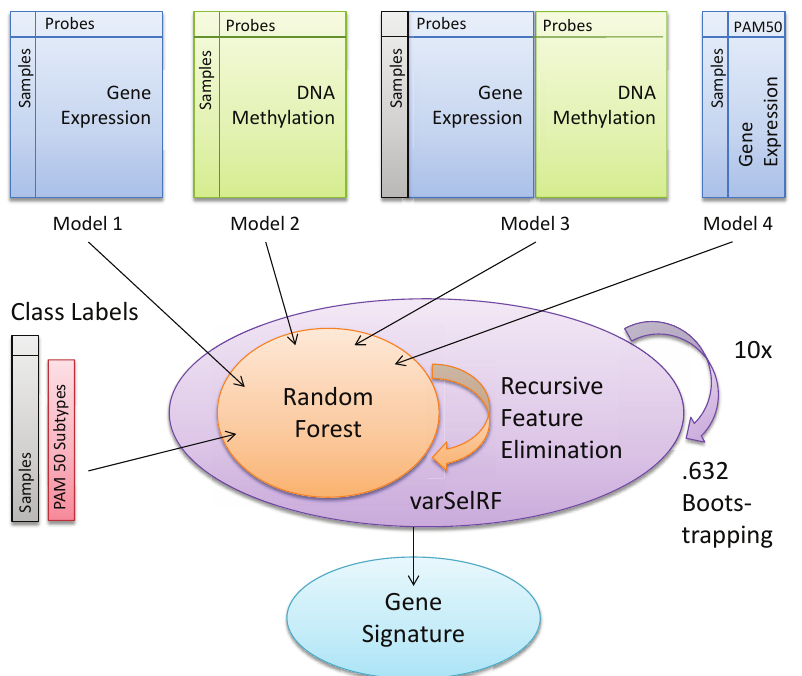
Figure 1: Four different models were created using gene expression data (1), DNA methylation data (2), a combination of both (3), and a gene expression data subset of 50 genes that are part of the gold standard PAM50, which also delivered the class labels [6] (4). The R package varSelRF was applied in 10 independent bootstrap runs to obtain a minimal set of features for classification. To this end, the feature space was recursively reduced by removing insignificant